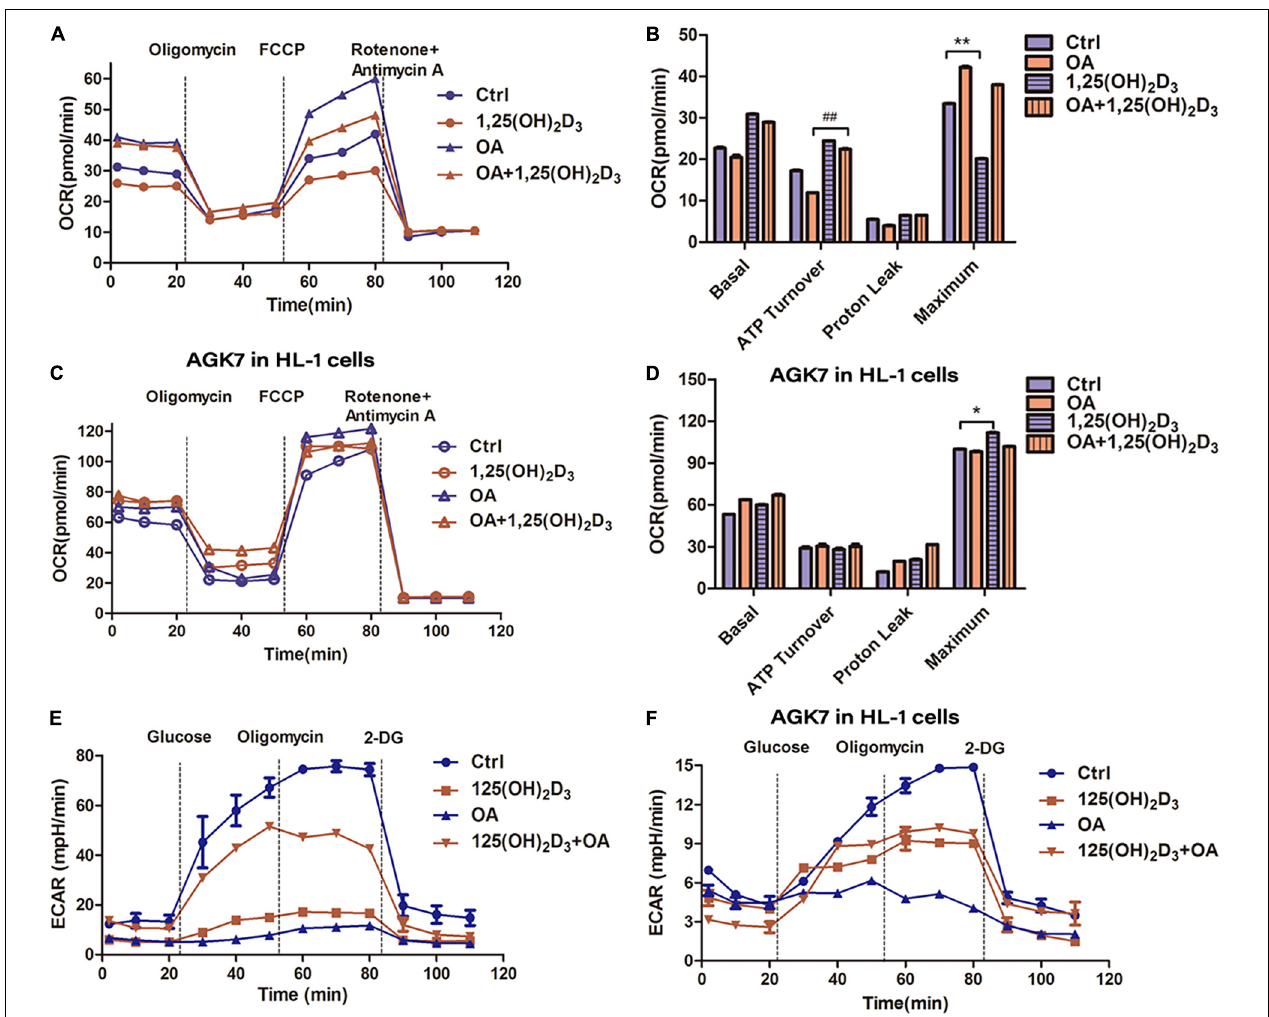
FIGURE 6 | VD/VDR regulated energy substrate homeostasis in HL-1 cells via SIRT3. (A) Analysis of oxygen consumption rate (OCR) in the mitochondria of HL-1 cells treated with 1,25(OH) 2 D 3 and OA. (B,D) The analysis of OCR in HL-1 cells treated with 1,25(OH) 2 D 3 , OA, and AGK7, indicating that VD treatment had no effect in the absence of SIRT3 * p < 0.05, ** p < 0.01, ## p ≤ 0.01. (C) ATP turnover was determined based on the OCR prior to oligomycin minus the OCR after oligomycin, indicating that mitochondrial respiration was decreased, and ATP was increased in the 1,25(OH) 2 D 3 + OA-treated cells compared with the